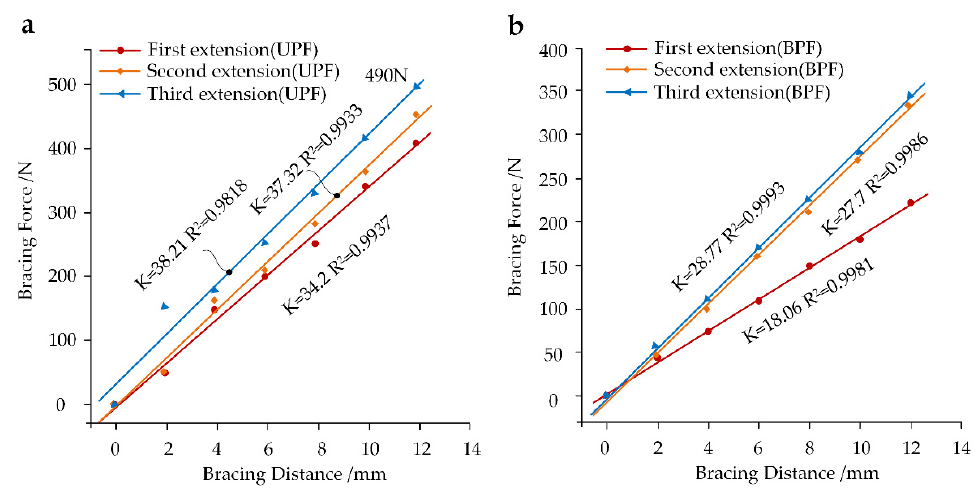
Figure 12. The bracing force of the growing rod in three surgical procedures. ( a ) The liner relation between bracing distance and bracing force after UPF; ( b ) The liner relation between bracing distance and bracing force after BPF. These data were normally distributed and significantly correlated at 0.01 level according to the Shapiro–Wilk test ( p > 0.05) and Pearson correlation. K represents the slopes of the curves and R 2 represents the regression coefficients of bracing force against the bracing distance.